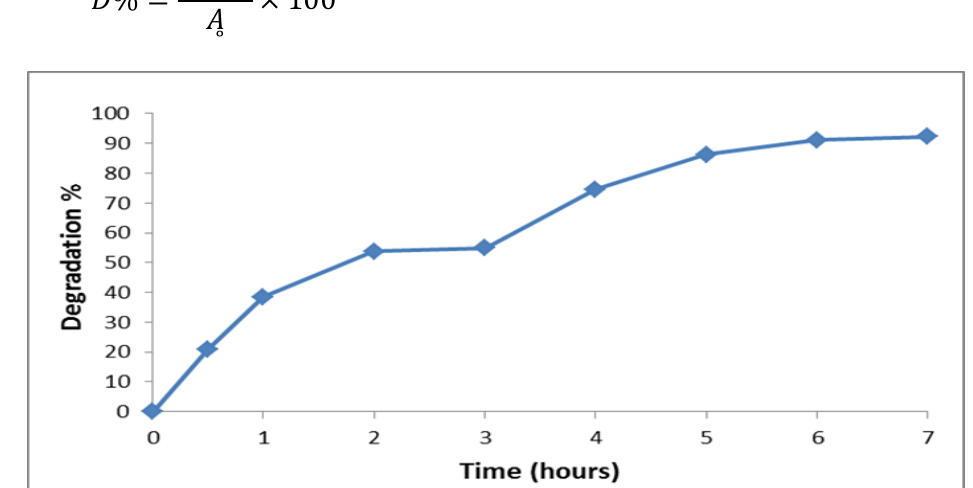
Fig.7: Degradation percentage versus time of